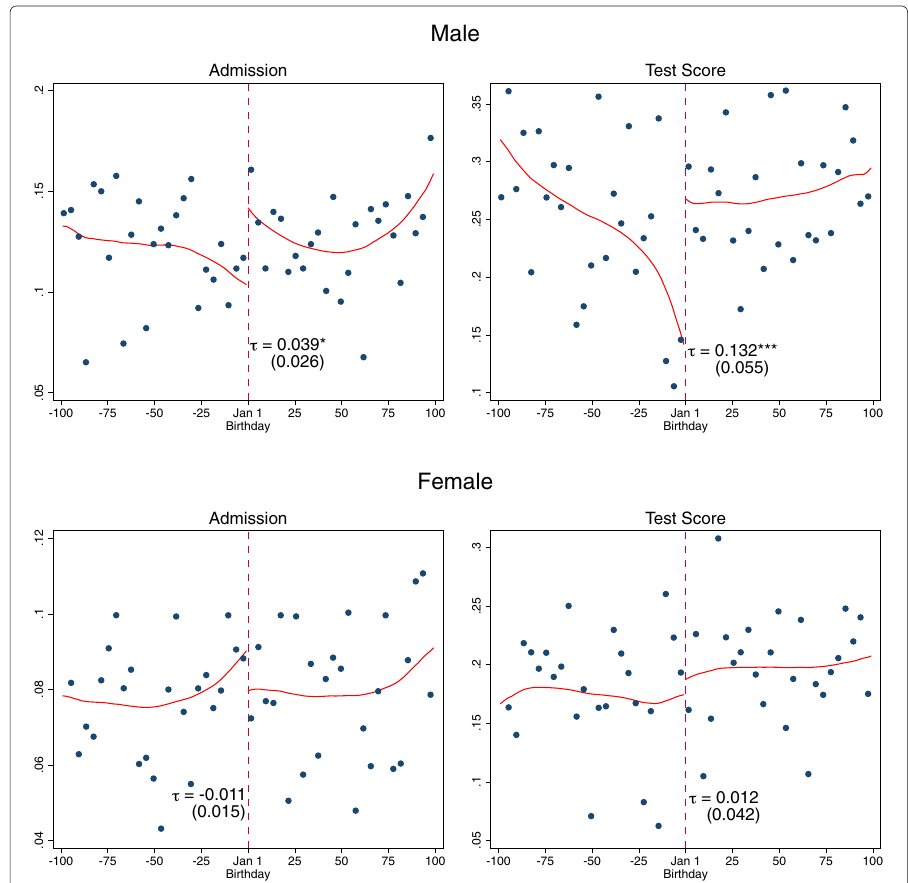
Fig. 7 Probability of college admission and test scores. This figure shows the relationship between birthday and college admission (on the left), as well as between the birthday and the college entrance test score (on the right). The center of the graphs is zero, which represents January 1. The first graphs at the top show the relationship for boys, and the ones at the bottom show that for girls. Data come from applications for undergraduate programs at UFPE from 2002 to 2005. The sample is restricted to those who graduated from high school in the same year and were under 18.5 years old. Functions are estimated using a triangular kernel with the bandwidth selection procedure proposed by Calonico et al. (2014). τ is the RD estimate, with robust standarderrors in parentheses .***,**, * represent statisticalsignificance at the 1, 5, and 10 % levels, respectively